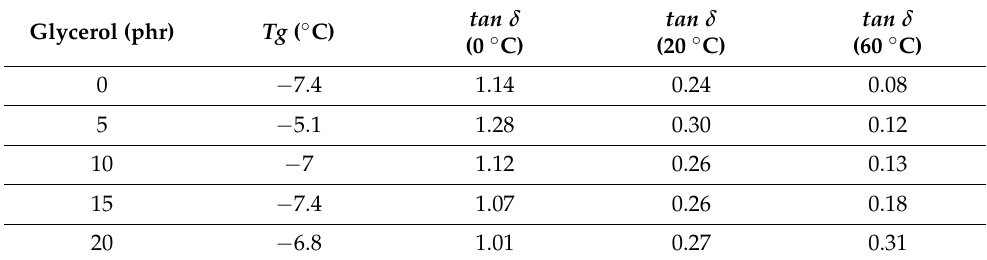
Table 4. Glass transition temperature and tan δ for vulcanizates based on